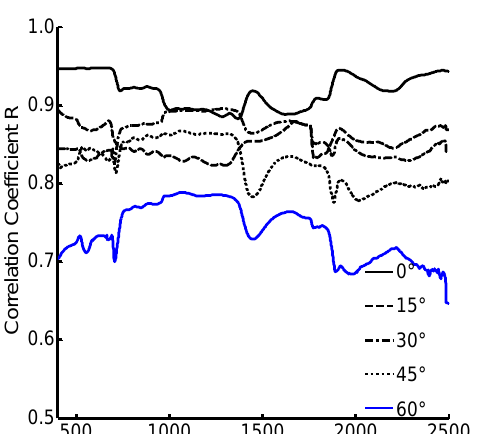
Figure 7. Correlation Coefficient R (left graph) and Root Mean Square Error (right graph) between measured data not participating in the inversion process and RPV reflectance for different light source zenith